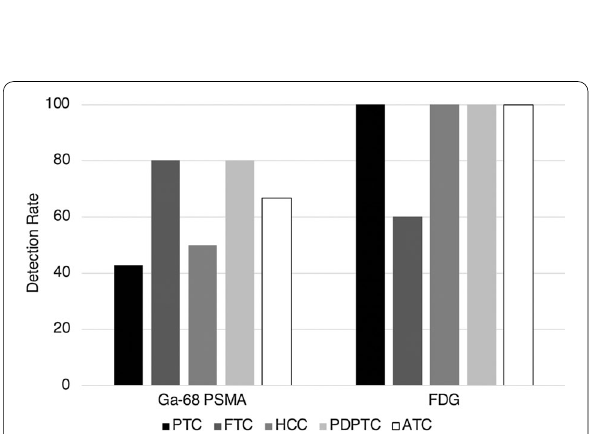
Fig. 1 Detection rate of [ 68 Ga]Ga‑PSMA‑11 and 2‑[ 18 F]FDG PET by thyroid cancer subtype. PTC: papillary thyroid carcinoma. FTC: follicular thyroid carcinoma. HCC: Hurthle cell carcinoma. PDPTC: poorly differentiated papillary thyroid carcinoma. ATC: anaplastic